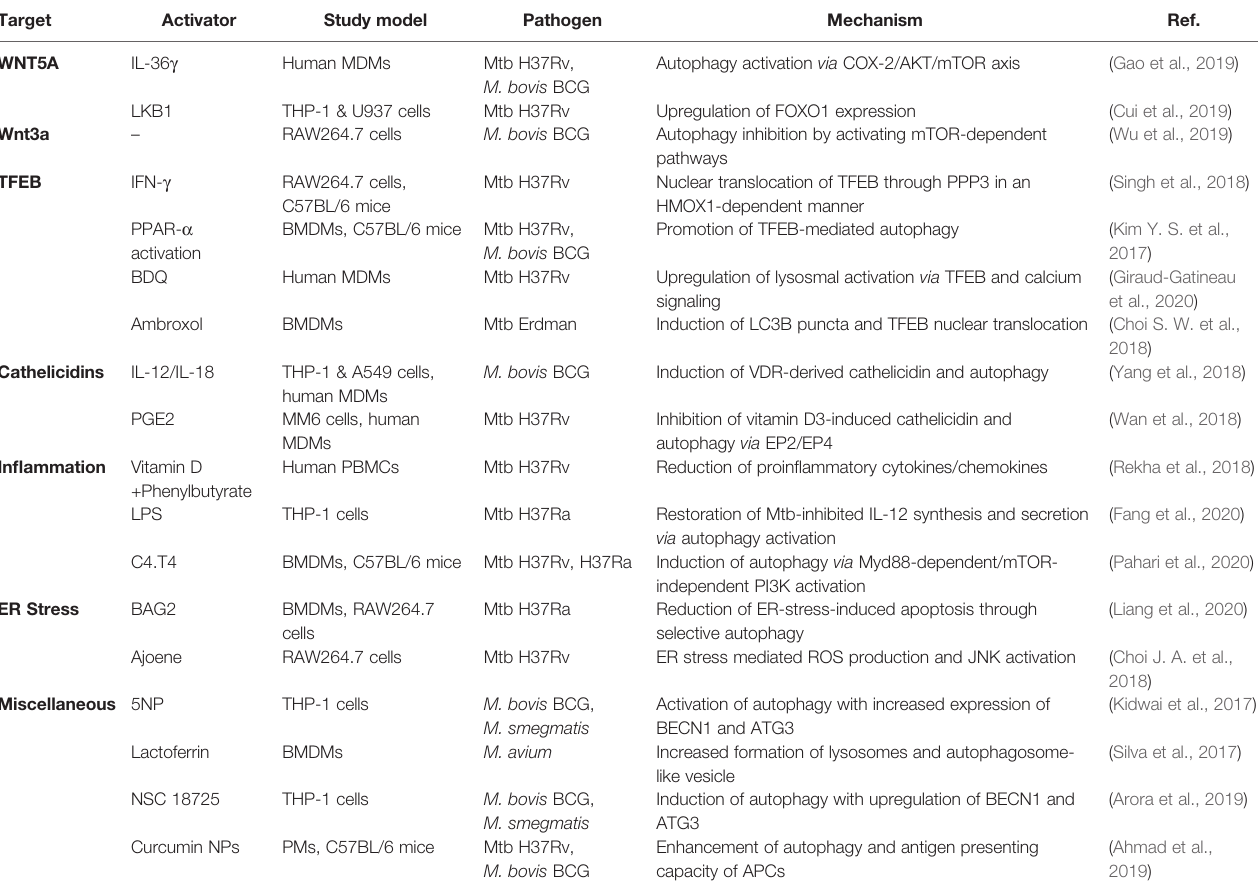
TABLE 2 | Autophagy-based antimicrobial responses against mycobacterial